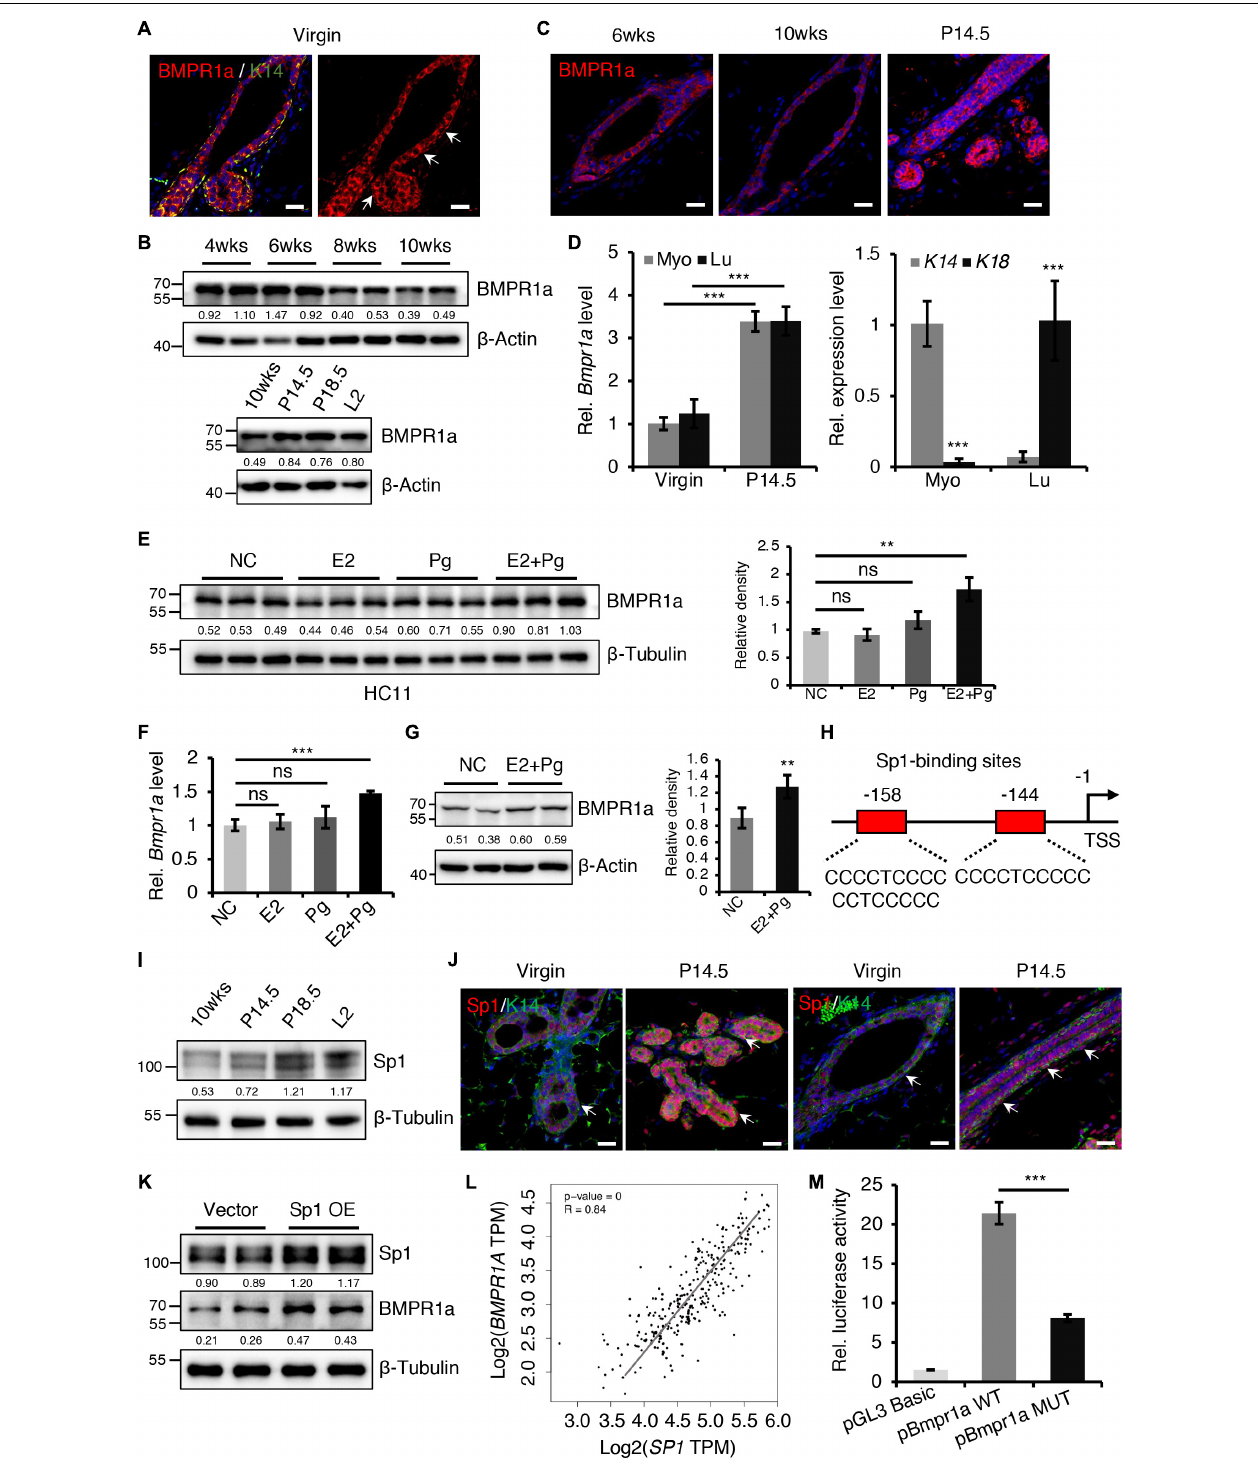
FIGURE 1 | BMPR1a was upregulated by hormones during pregnancy. (A) Immunofluorescence staining for BMPR1a (red) and K14 (green) in 6-week-old wild-type mouse mammary gland ducts and terminal end buds. Arrows point to myoepithelial cells. n = 3 mice. Scale bar, 25 µ m. (B) Western blotting for BMPR1a in isolated mammary gland epithelial cells at the indicated developmental stages (P14.5, pregnancy day 14.5; P18.5, pregnancy day 18.5; L2, lactation day 2). β -Actin was used as a loading control. (C) Immunofluorescence staining for BMPR1a in mammary glands of wild-type mice at the indicated time points (P14.5, pregnancy day 14.5). n = 3 mice per time point. Scale bar, 25 µ m. (D) qRT-PCR analysis of Bmpr1a in FACS sorted myoepithelial (Myo) and luminal (Lu) cells from wild-type mice at